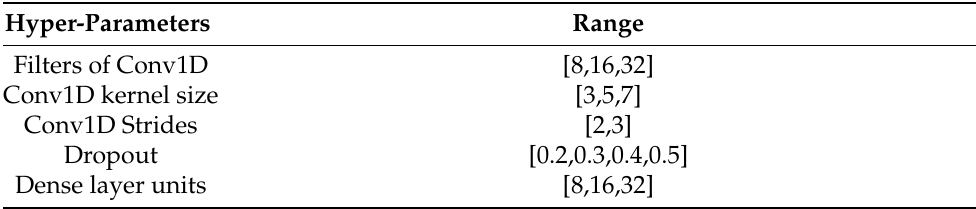
Table 2. The ranges of the tuned